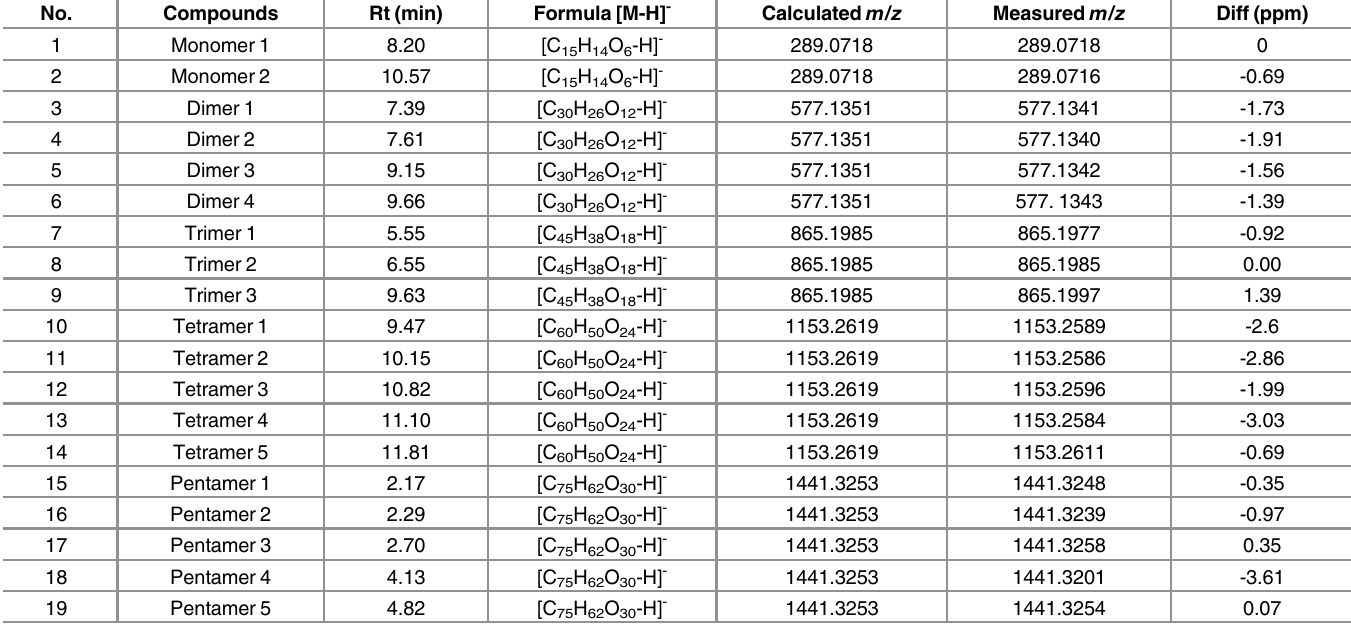
Table 2. HRMS identification data of purified